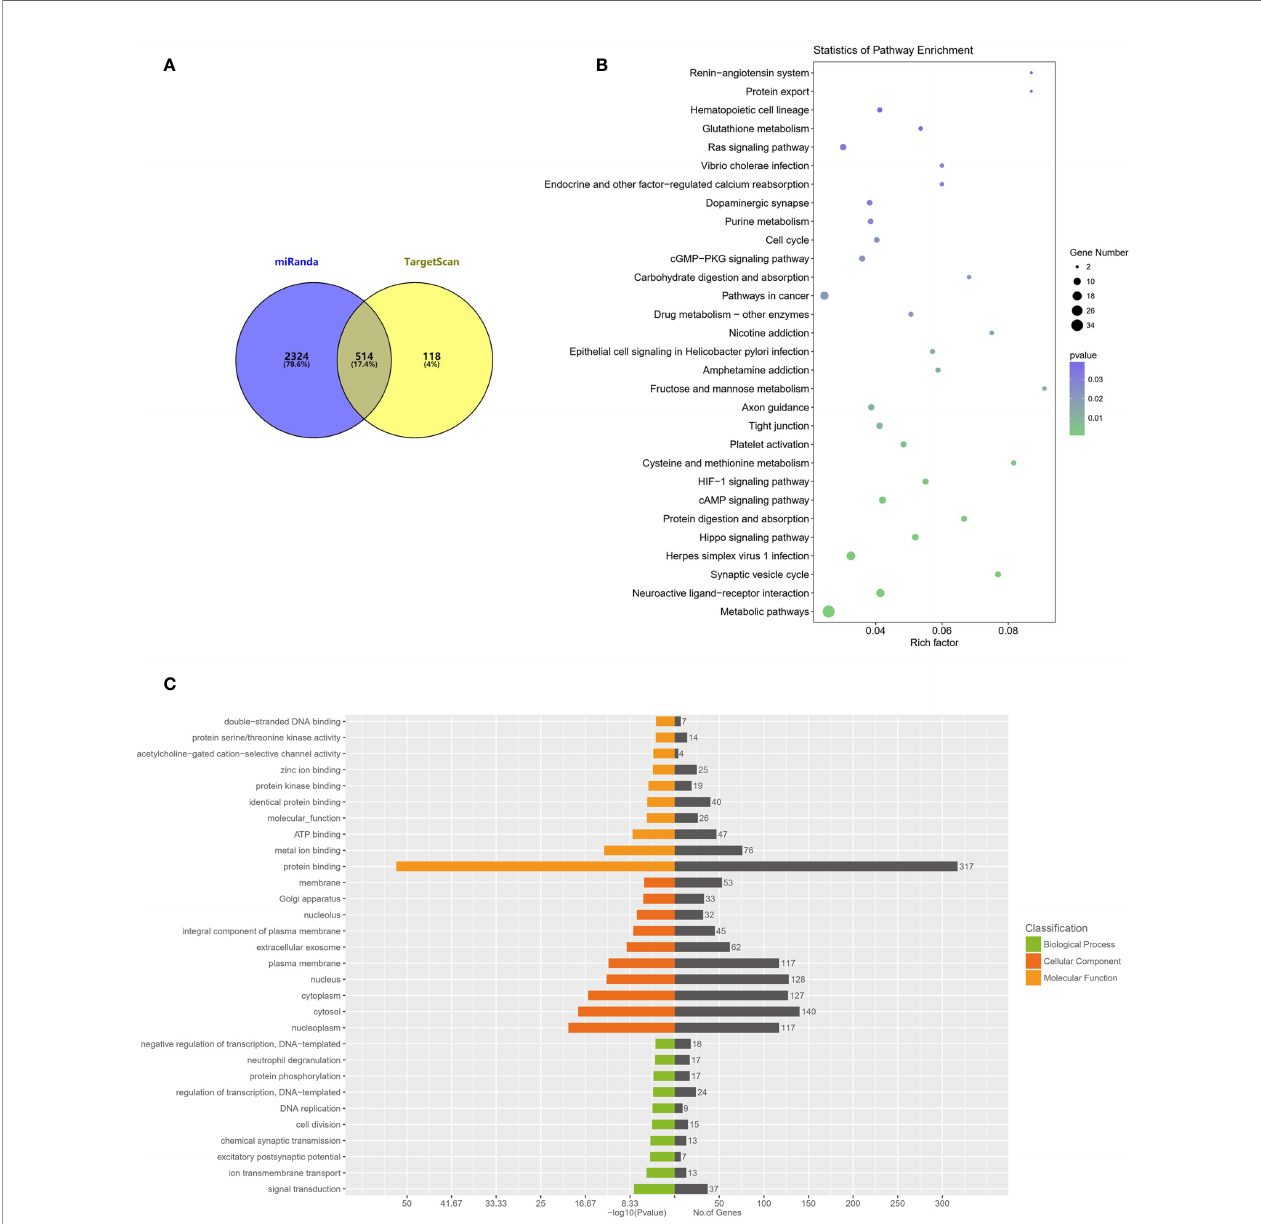
FIGURE 6 | GO and KEGG enrichment analyses of tRF-31-U5YKFN8DYDZDD target genes. (A) Schematic diagram of tRF-31-U5YKFN8DYDZDD target prediction. Venn diagram evaluated the overlapped genes between miRandan and TargetScan predictions. (B) Bubble chart of KEGG analysis of candidate tRF-31- U5YKFN8DYDZDD different target genes expressed of enriched pathways. (C) GO analysis of the tRF-31-U5YKFN8DYDZDD target genes enriched in biological process, cellular component, and molecular